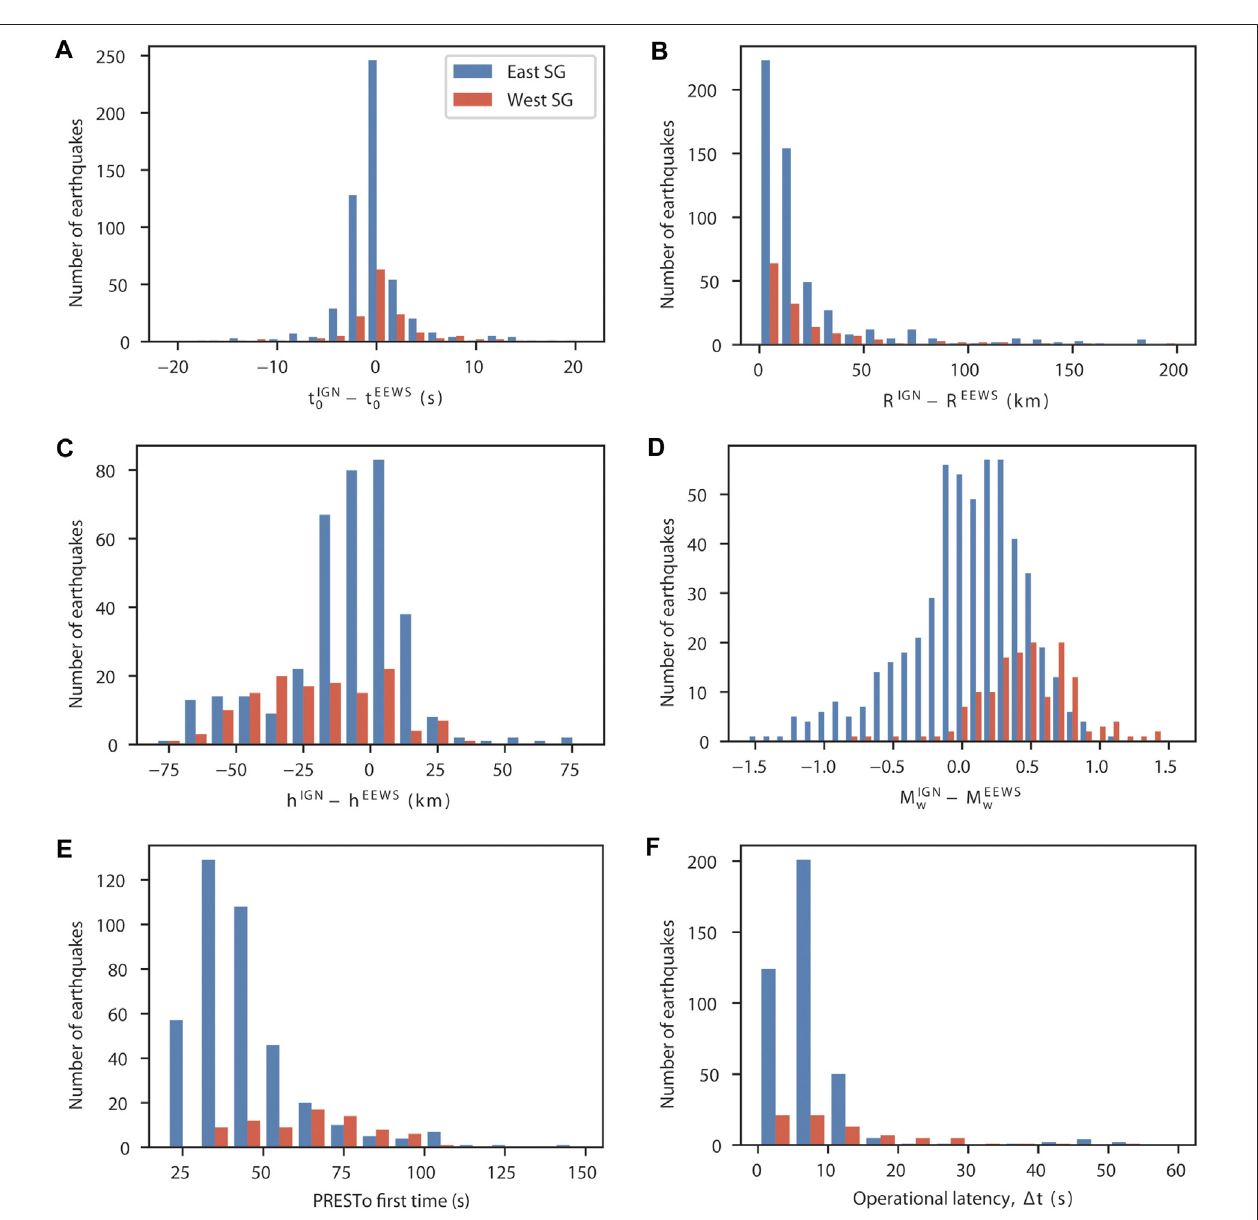
FIGURE 4 | Comparison between IGN and PRESTo fi nal estimations: (A) difference on origin time, (B) epicenter, (C) on depth, (D) on M w , (E) PRESTo fi rst time estimation, and (F) the operational latency. Red bars correspond to earthquakes located in the western Strait of Gibraltar, and blue bars correspond to earthquakes located in the eastern Strait of Gibraltar